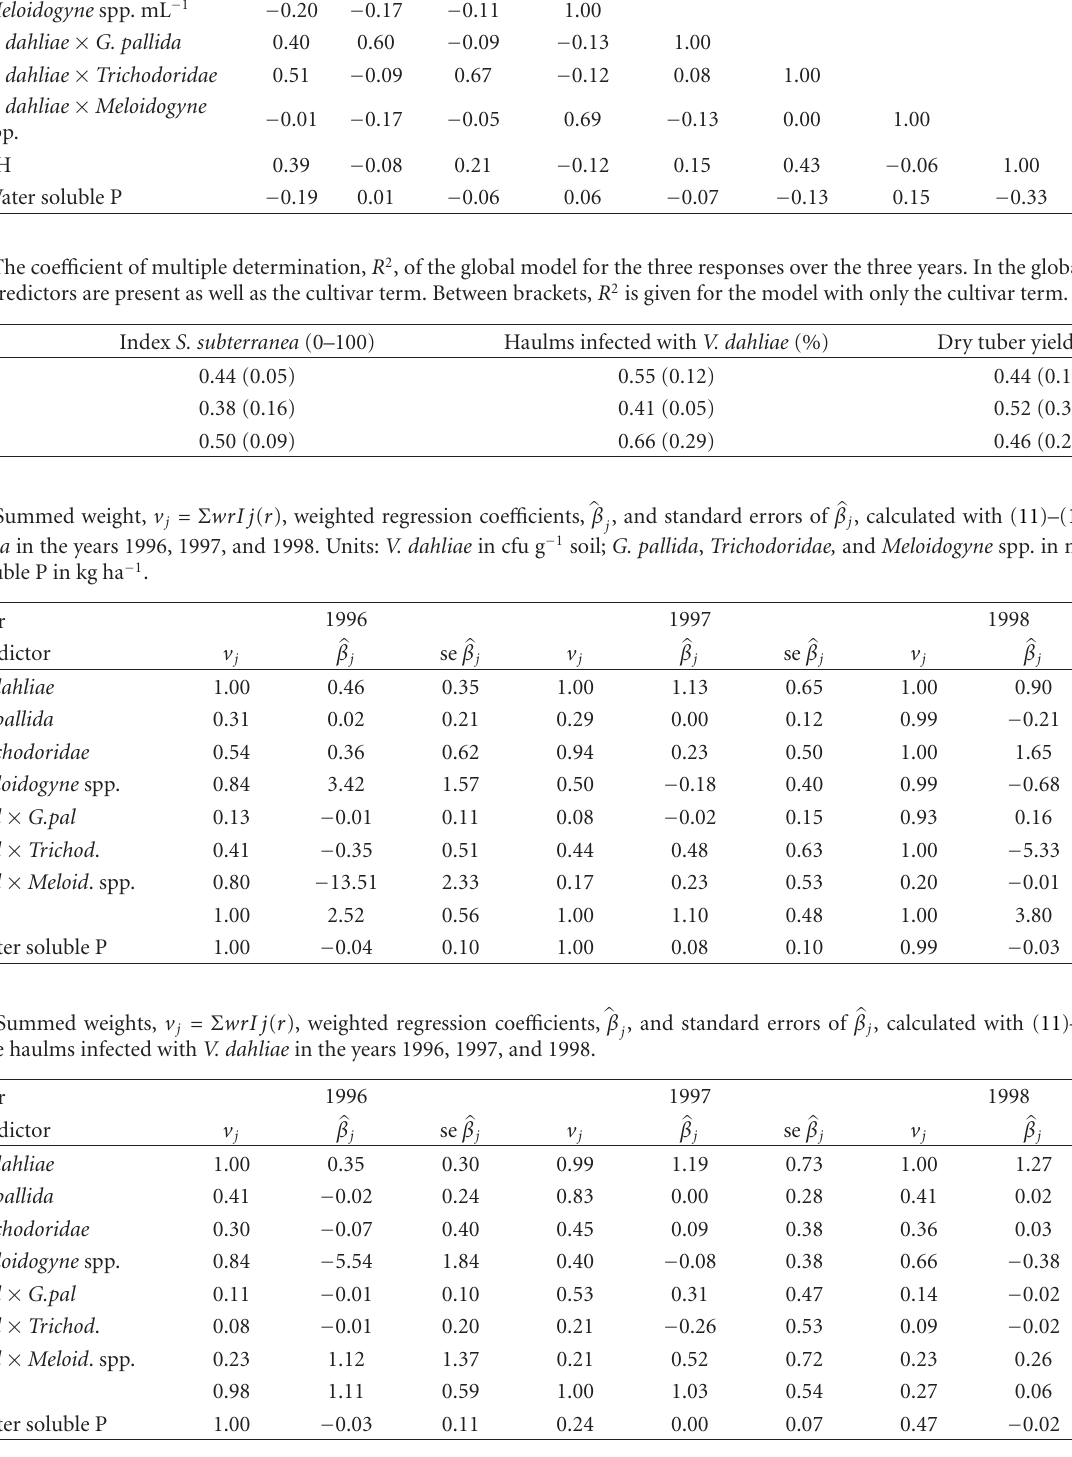
Table 1: Correlation matrix for the nine predictors in the year 1998. There are 108 pairs in each correlation. Units: V. dahliae in cfu g − 1 soil; G. pallida , Trichodoridae, and Meloidogyne spp. in mL − 1 and Water soluble P in kg ha − 1 .